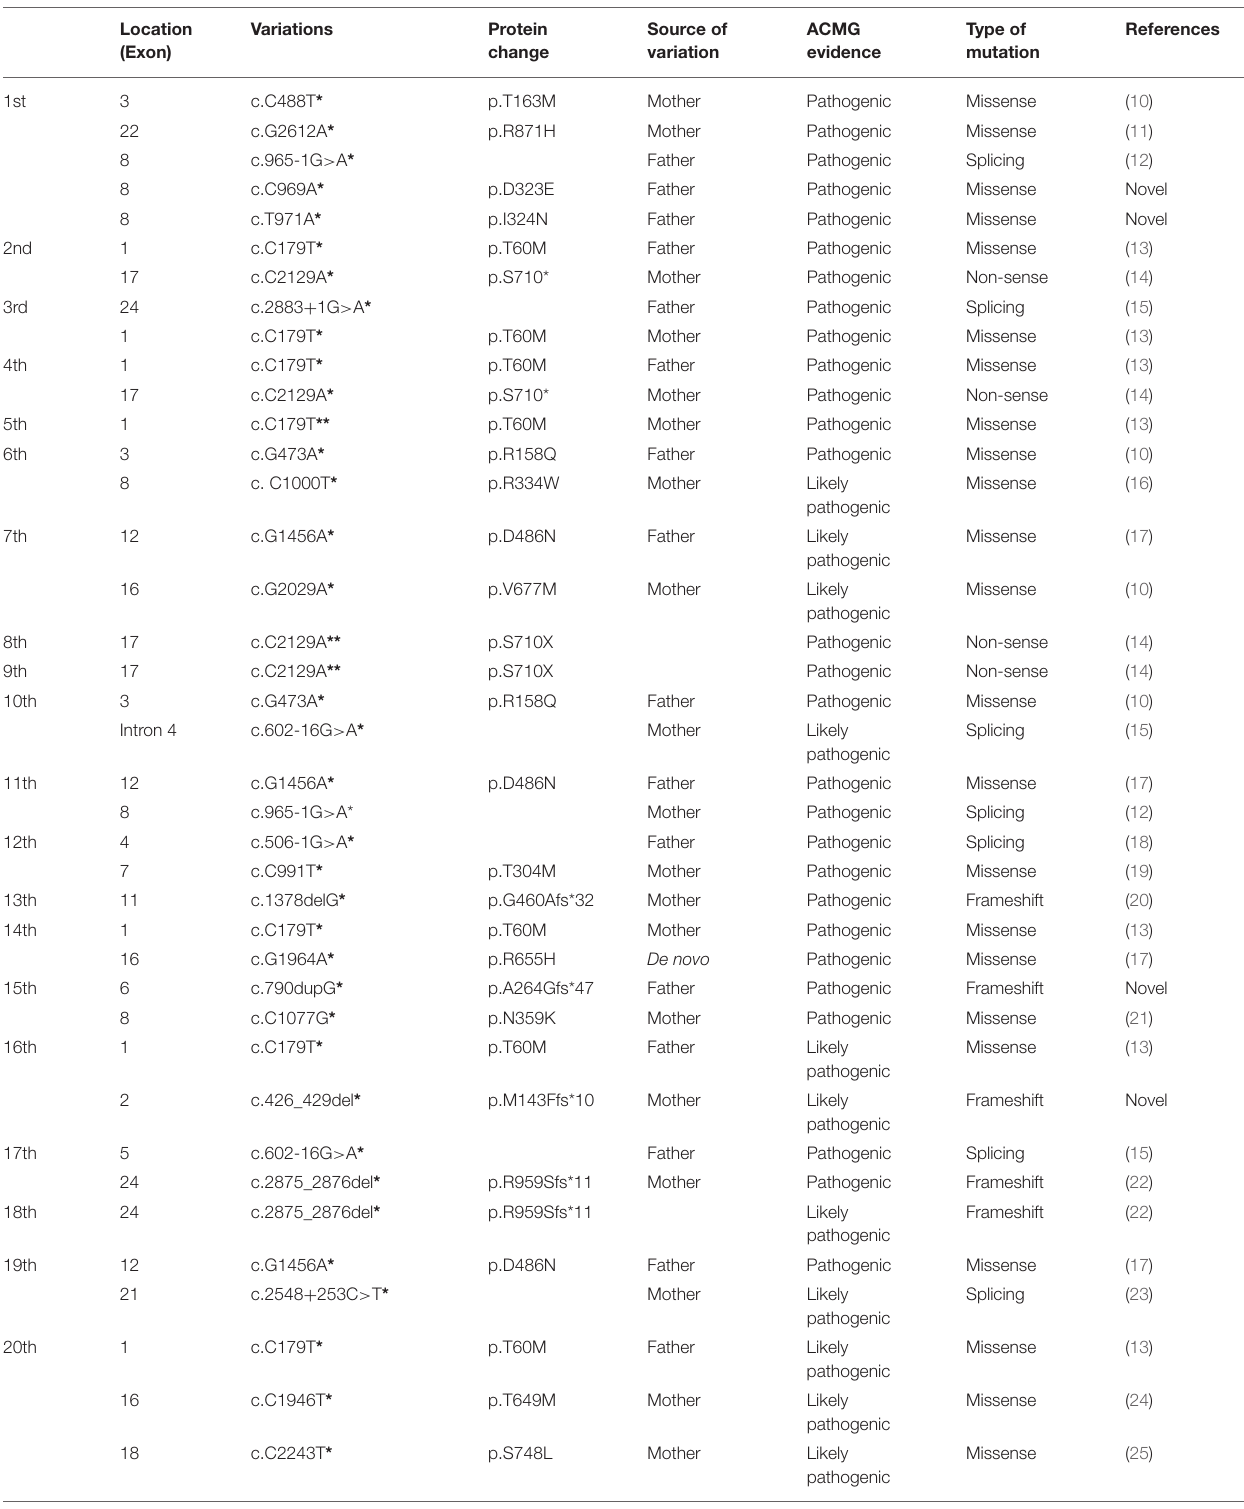
TABLE 2 | SLC12A3 mutations by WES and corroborated sanger sequencing in patients with clinically diagnosed GS. Location